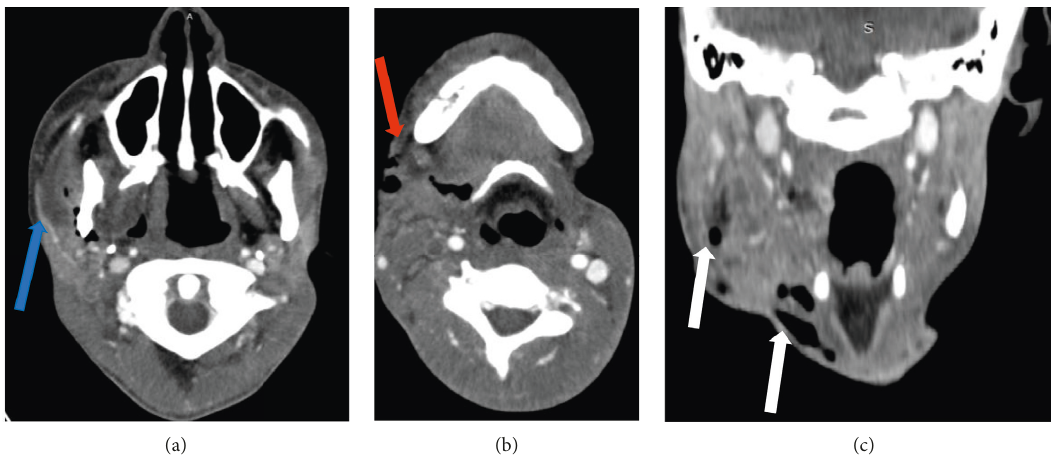
Figure 2: Cervical CTscan with contrast injection. (a) Axial view showing right masticatory area fluid collection (blue arrow). (b) Axial view showing fistulous path to the skin (red arrow). (c) Coronal view showing heterogeneous content of the collection with air bubbles (white arrows).